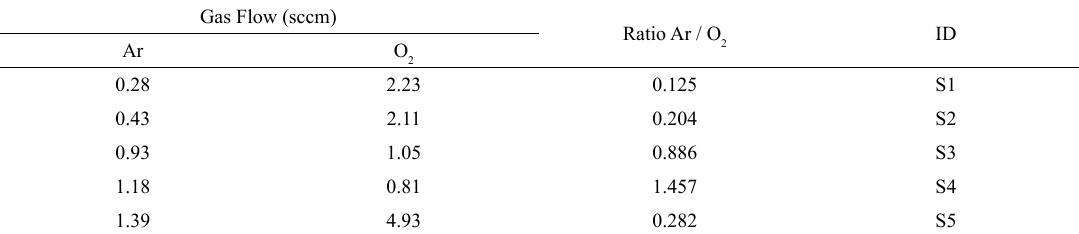
thin films on steel. 2